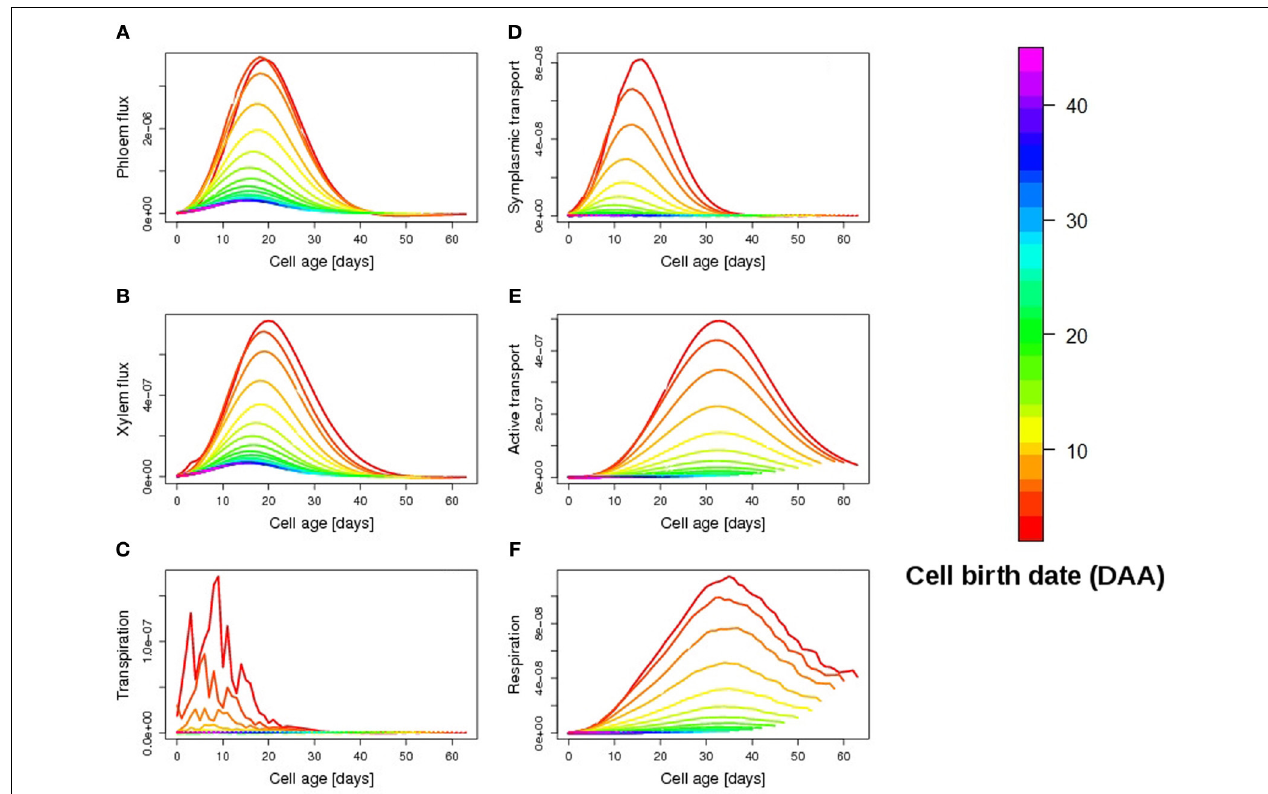
FIGURE 6 | Temporal evolution of simulated cellular fluxes (daily mean) as a function of cell age: phloem flux (A), (g water/h), xylem flux (B), (g water/h), transpiration (C), (g water/h), symplasmic